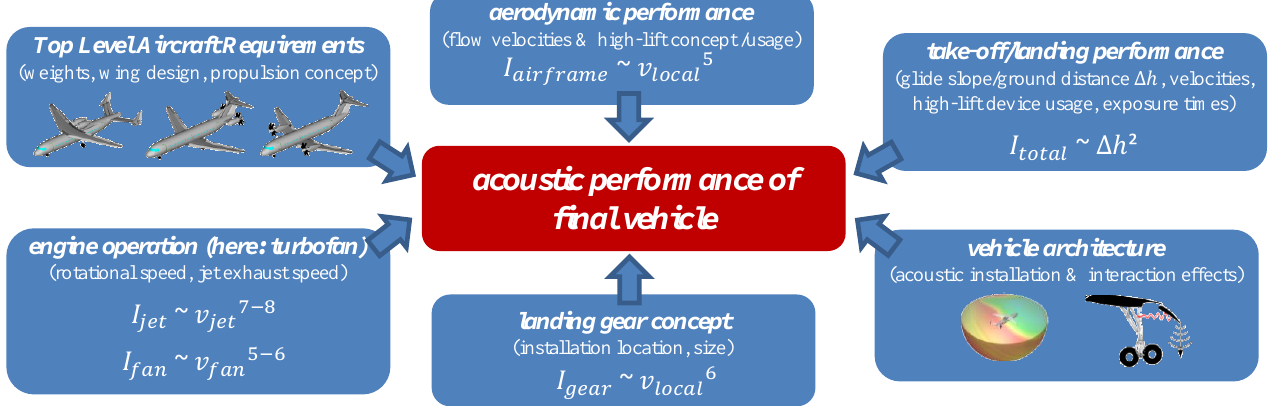
Figure 1. Influence of design options on acoustic performance of resulting vehicle (changed, originally from Ref.